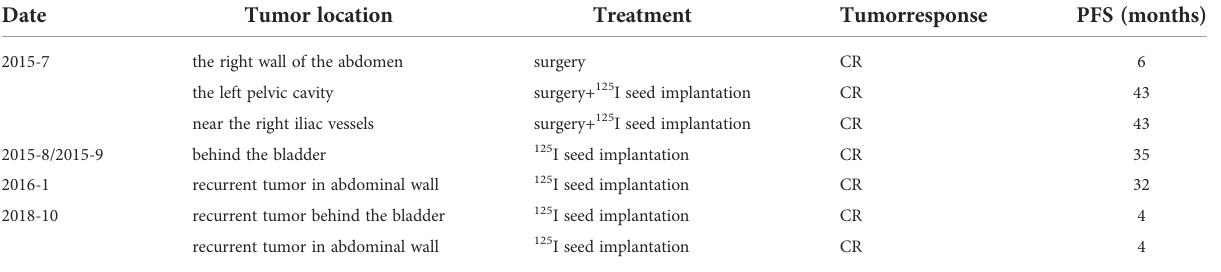
TABLE 1 The characteristics of treatment methods and ef fi